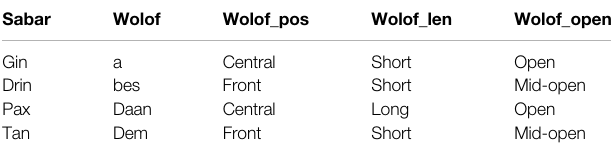
TABLE 4 | Example of restructured